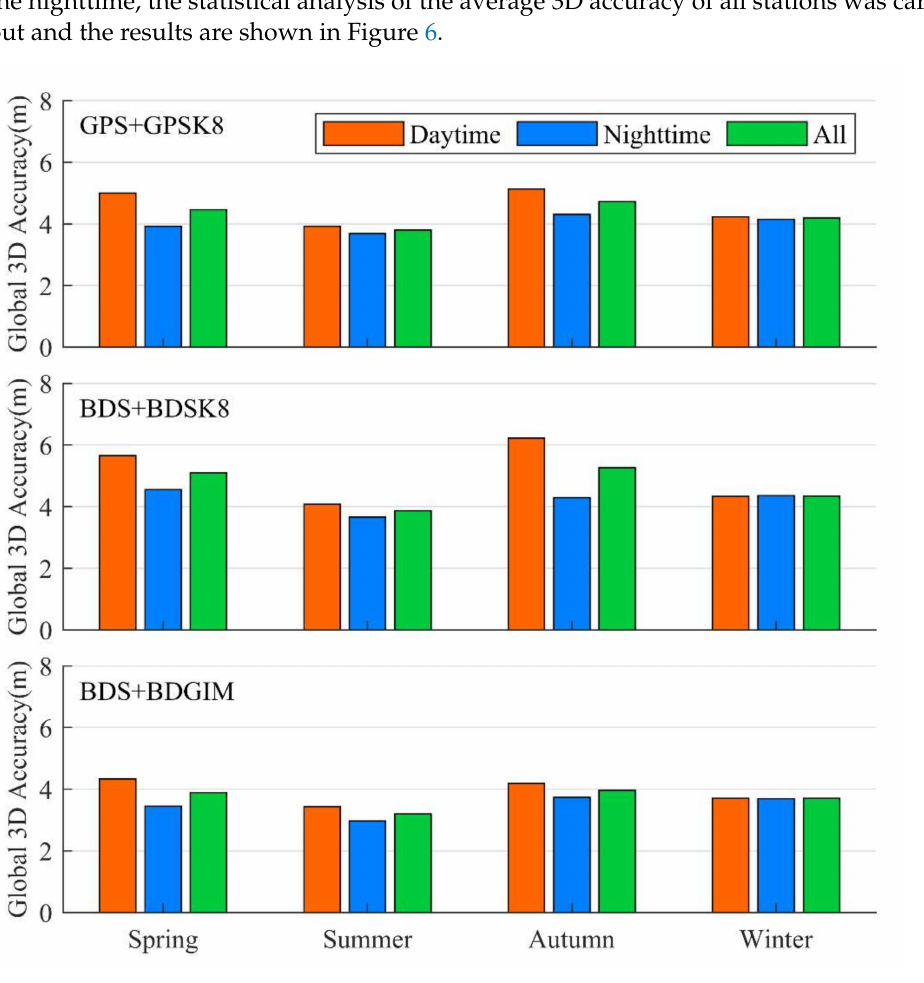
Figure 6. Global average 3D positioning accuracy for different seasons and periods for GPS + GPSK8, BDS + BDSK8, and BDS +